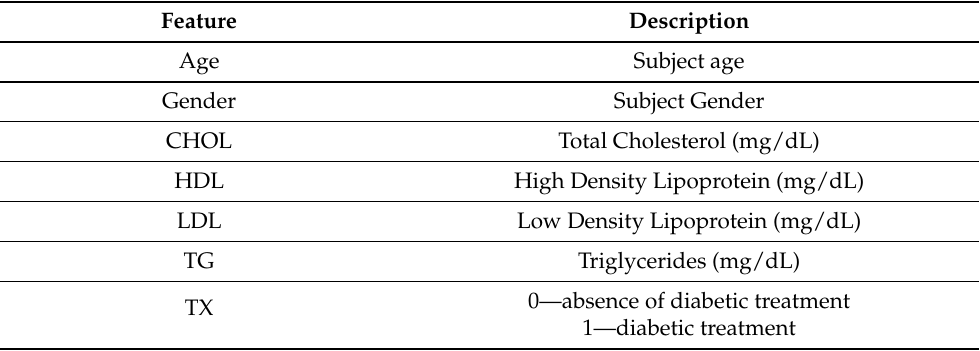
Table 1. Description of features contained in the